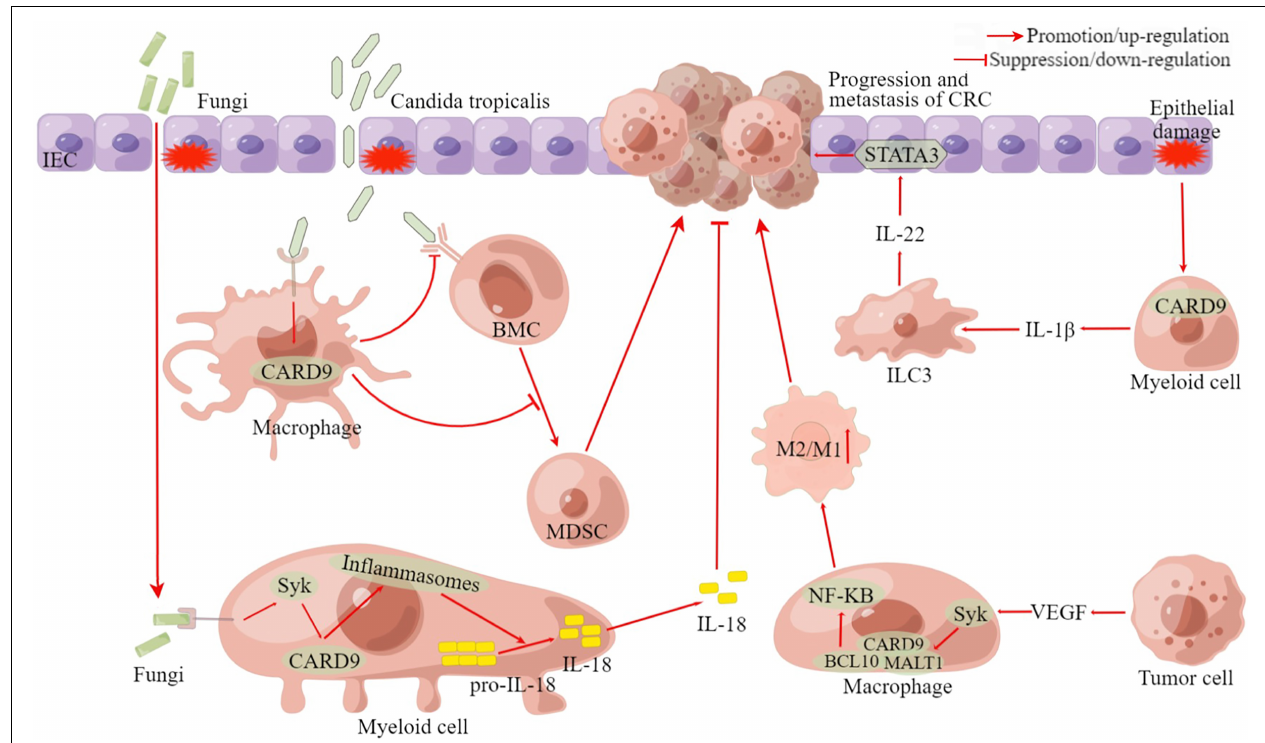
FIGURE 4 | The pro-cancer and anti-cancer roles of CARD9 in CRC. BMC, bone marrow cell; MDSC, myeloid-derived suppressor cell; ILC3, group 3 innate lymphoid cell; CRC, colorectal cancer; VEGF, vascular endothelial growth factor; STAT3, signal transducer and activator of transcription 3; BCL10, B-cell leukemia-lymphoma 10; MALT1, mucosa-associated-lymphoid-tissue lymphoma-translocation gene 1; Syk, Spleen Tyrosine Kinase; IEC, intestinal epithelial cell; CARD9, caspase recruitment domain-containing protein 9; M1/M2, M1 macrophage/M2 macrophage; IL, Interleukin. This figure was created using Figdraw